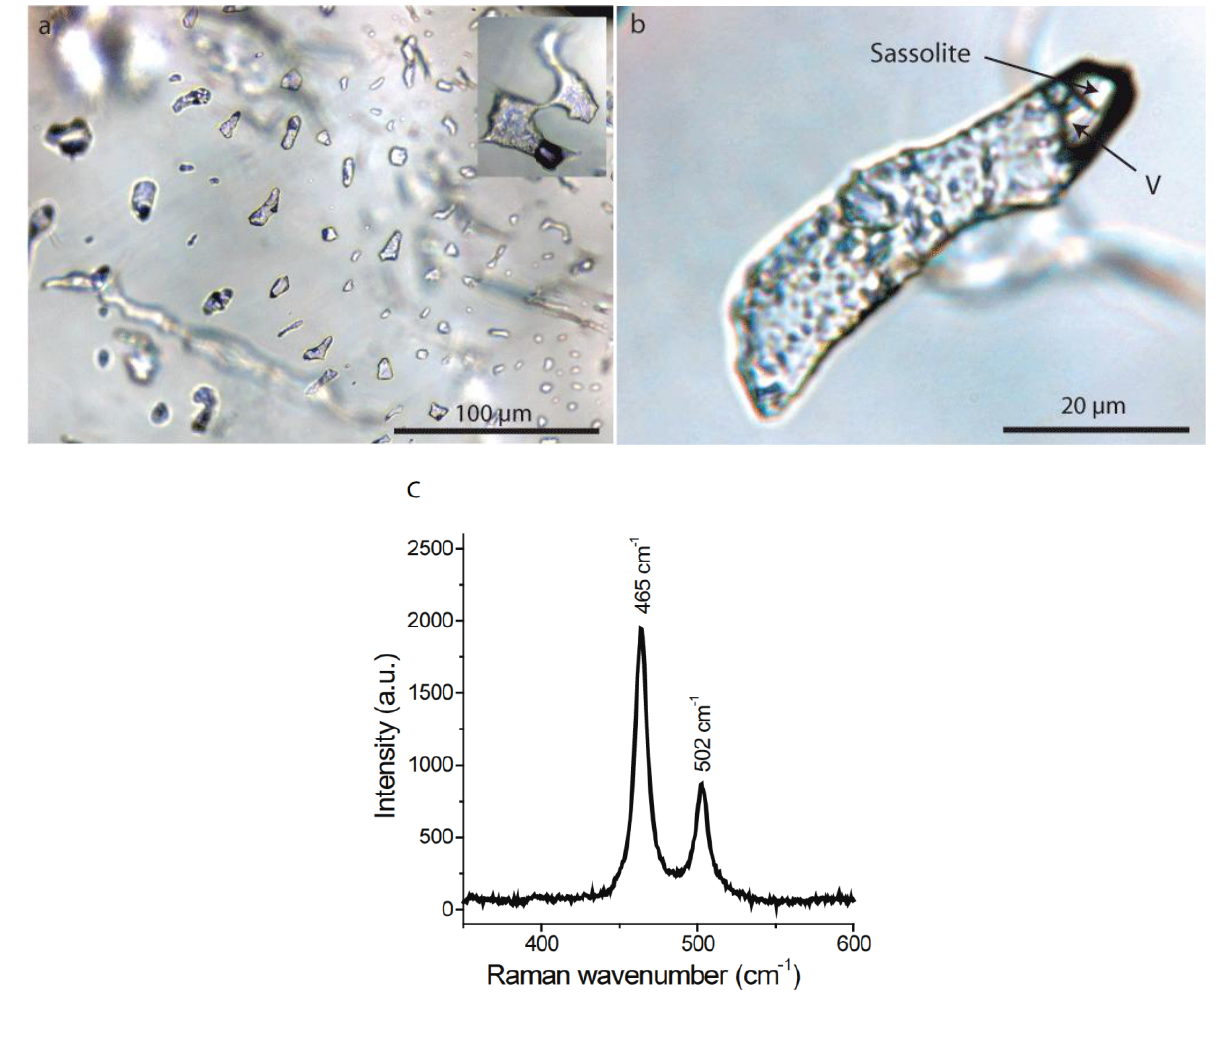
Figure 8. Photomicrographs of gel-like inclusions from the Malkhan pegmatites, ( a ) gel-like inclusions in low temperature achroite, a colorless variety of tourmaline. The insert is a larger inclusion in the same growth zone, but out of the focal plane; ( b ) is a single typical gel-like inclusion, primarily containing quartz grains, small amounts of cristobalite and a carbonate- and H BO -bearing solution; see also Thomas and 3 3 Davidson [31, Figure 6]. A Raman spectra in the range 350–600 cm −1 from grains in the inclusion is shown in ( c ). The labeled bands at 465 cm −1 and 502 cm −1 are the main symmetric stretching-bending modes of α-quartz and moganite